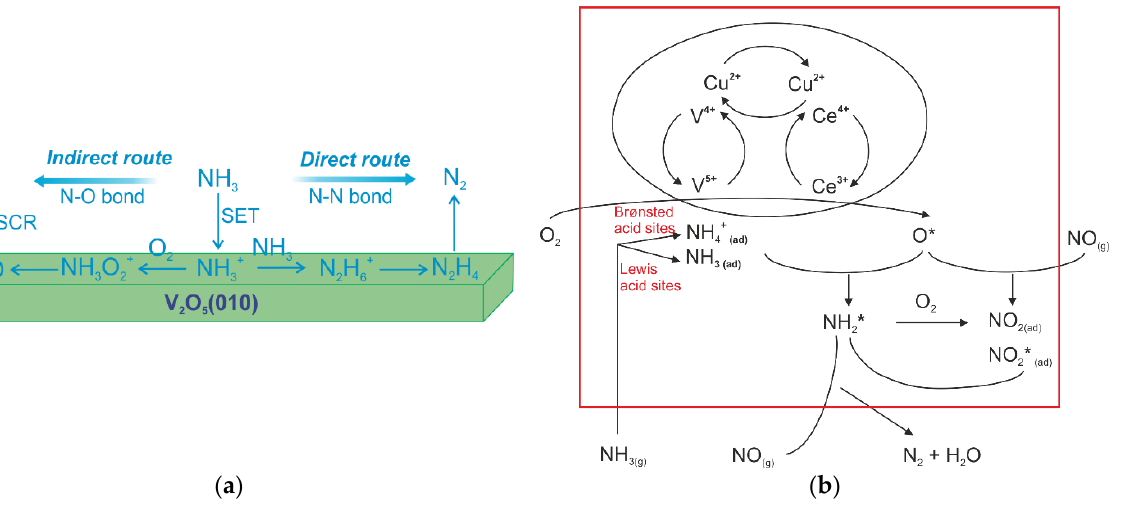
Figure 5. ( a ) Two competitive routes for NH 3 oxidation over V 2 O 5 (010). Reprinted from [55] with permission from ACS Publications; ( b ) schematic representation of the mechanism of NH 3 -SCO